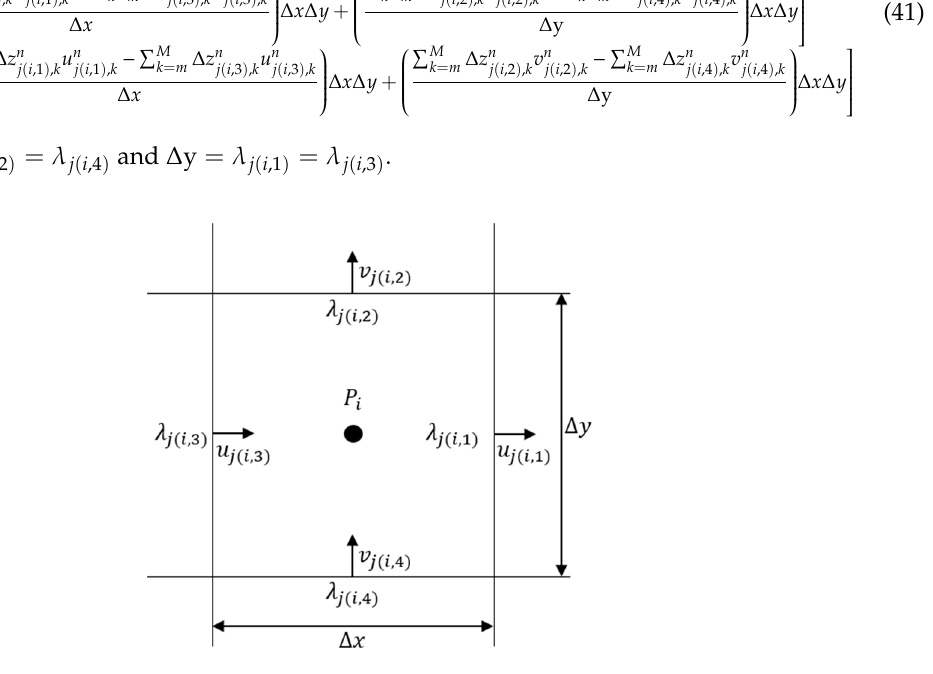
Figure 5. Numerical stencils of a rectangular grid for the finite volume method, where λ j ( i ,1 ) ∼ λ j ( i ,4 ) are the length of each cell face.